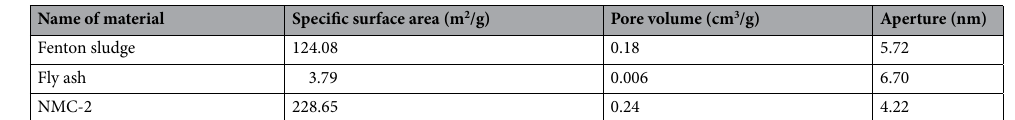
Table 1. Total pore-specific surface area, pore volume, and pore size of BJH adsorption and accumulation of Fenton sludge, fly ash and NMC-2.